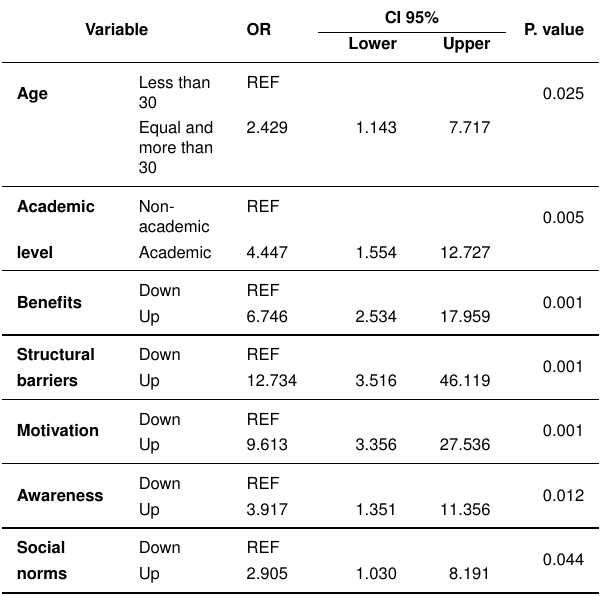
Table 6. Results of logistic regression on the determinants of source separation